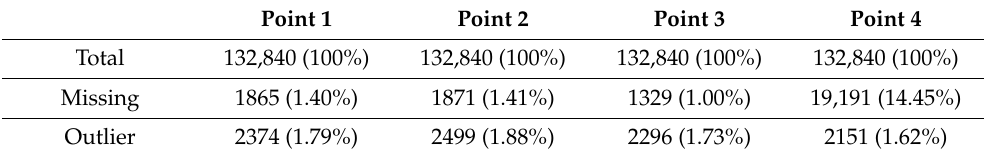
Table 2. Ratio of outliers and missing data at each metering